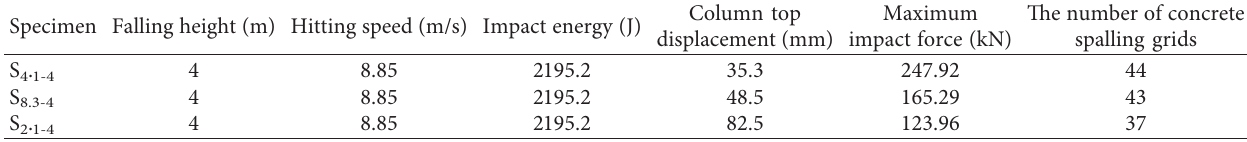
Table 8: Comparison about the most serious failure condition.